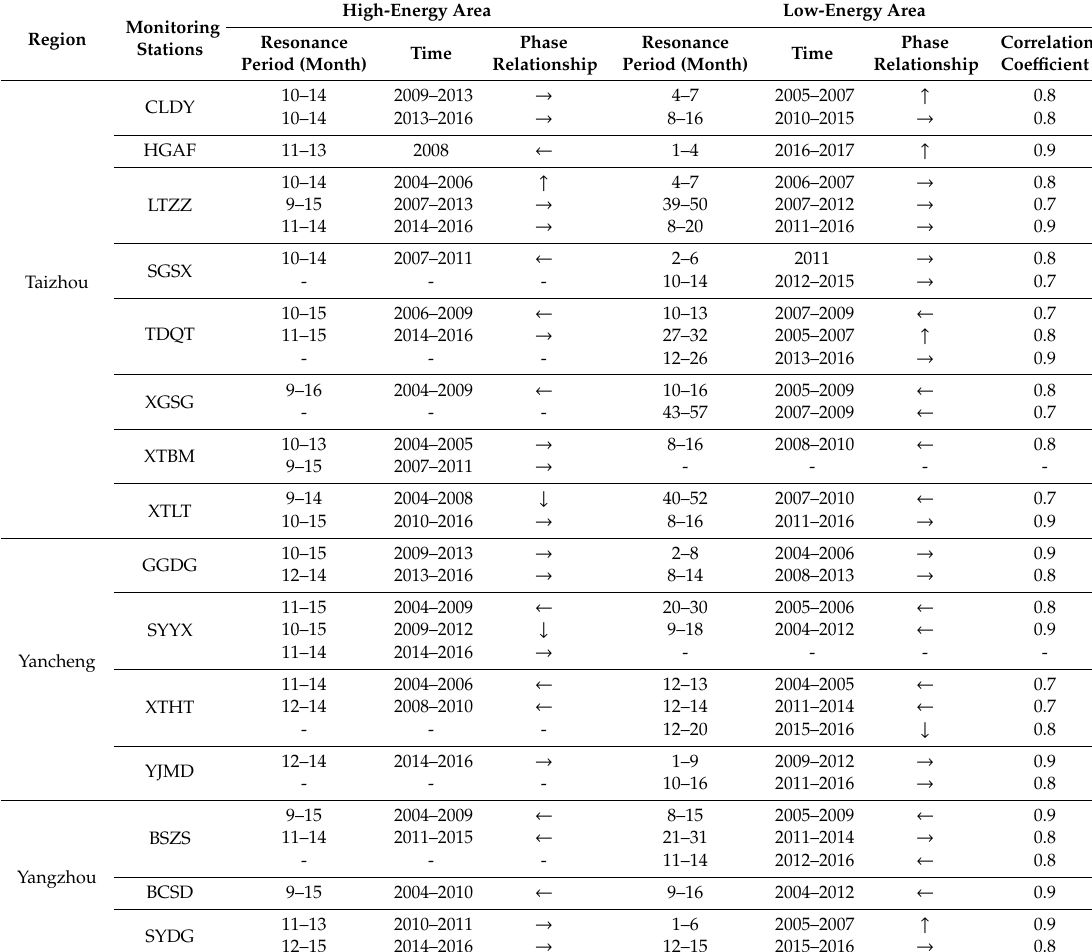
Table 7. Correlation between the CWQI and water